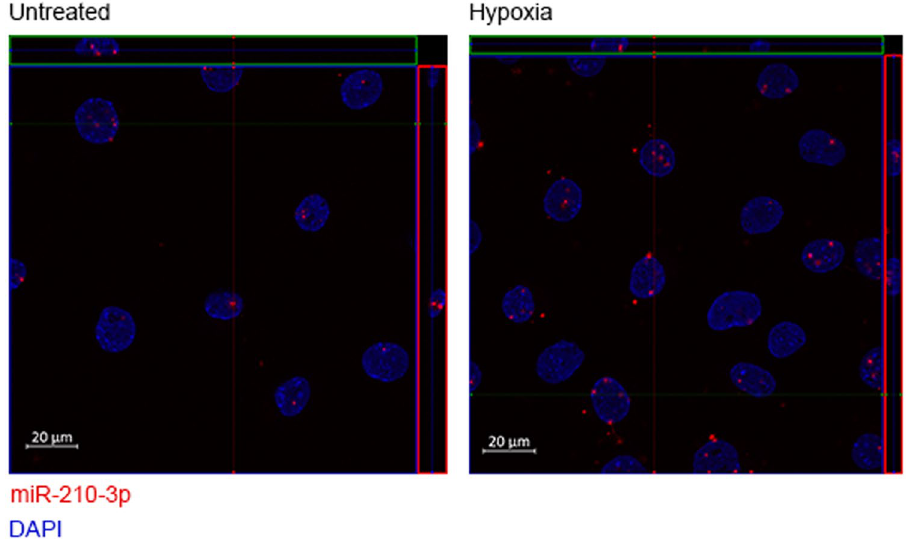
Figure 4. miR-210-3p localization upon hypoxic stimulus. miR-210-3p localization in C166 cells in normoxia and hypoxia (24 h) using fluorescent in situ hybridization (FISH). miR-210-3p is found in nucleus in normoxia and hypoxia. DAPI was used to stain nuclei of the cells. miR-210-3p is stained in red. To better display the co- localization of nuclear and miR-210-3p staining, areas within green and red rectangles show the view to the confocal microscopy image stack from the